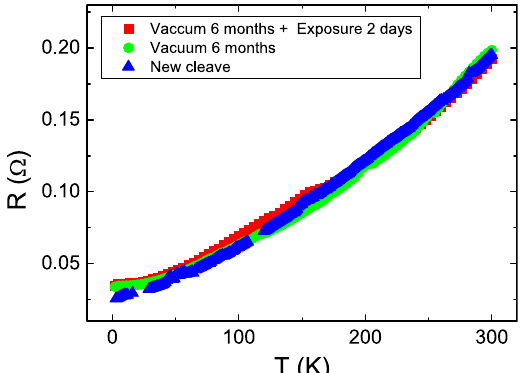
Figure 1. The temperature dependent resistance of newly cleaved, 6-months in vacuum, 2-days N 2 atmosphere exposed crystal. Metallic behavior was observed, and the residual resistance ratio was 5. Because resistances have the same temperature dependence. N 2 exposure time does not obviously influence the overall characteristics of the